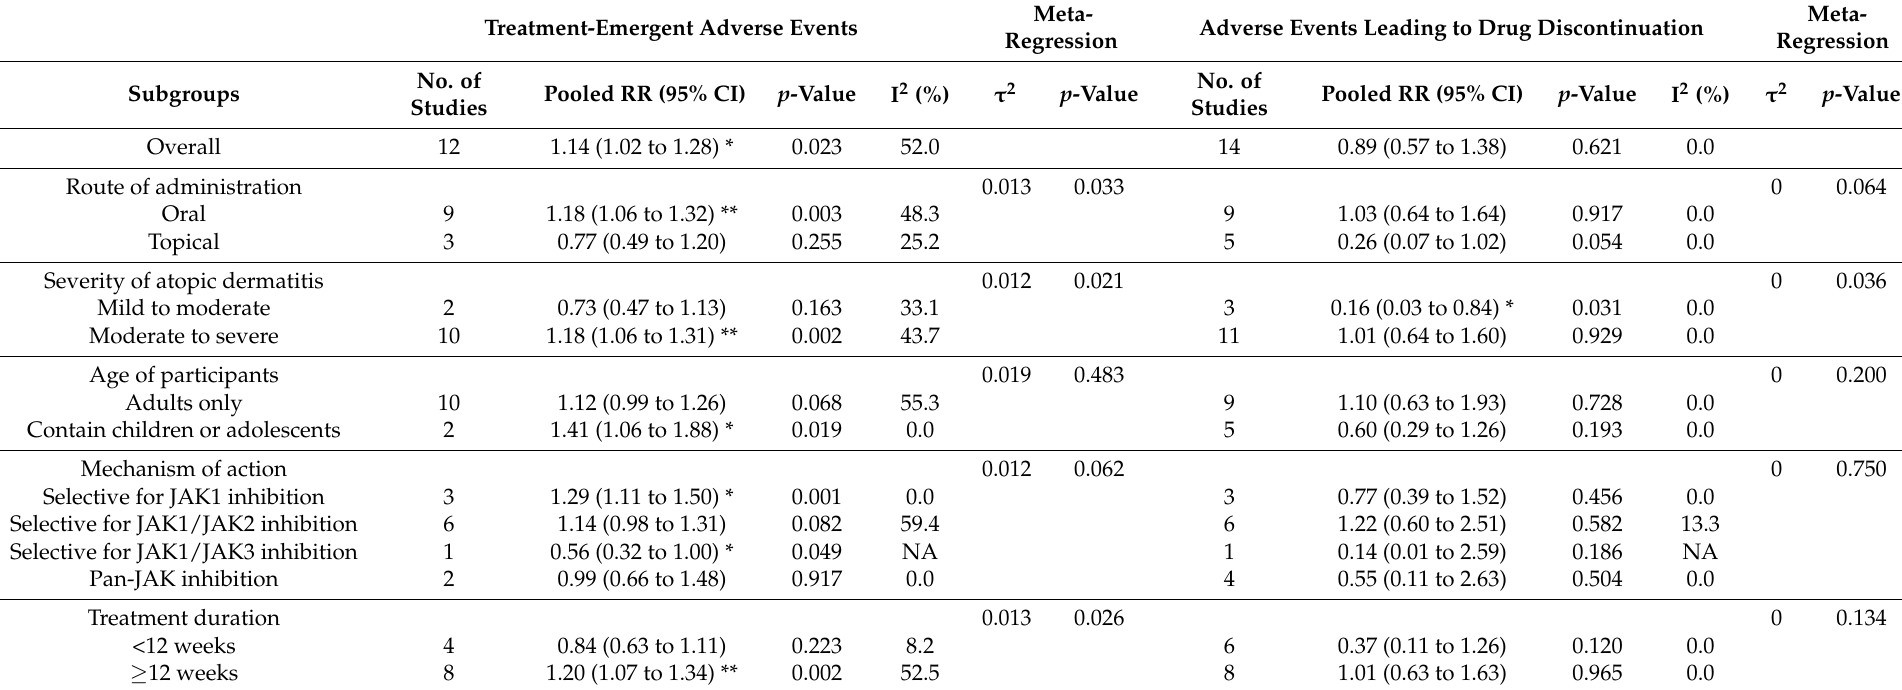
Table 2. Safety outcomes of Janus kinase